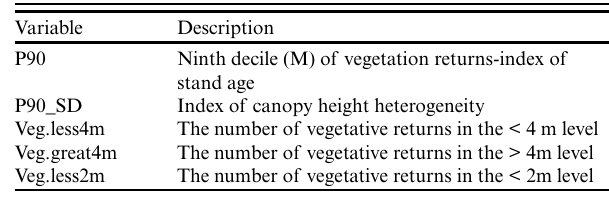
Table 2 . Light Detection and Ranging (LiDAR) metrics used to characterize forest vertical structure within sample plots (100 m radius circles) in each of 109 lowland black spruce